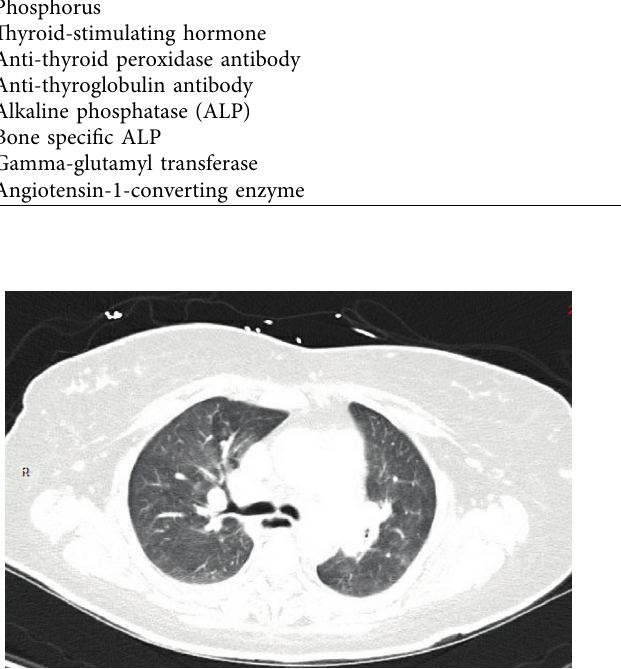
Figure 2: Chest computed tomography revealing mediastinal and hilar lymphadenopathy.